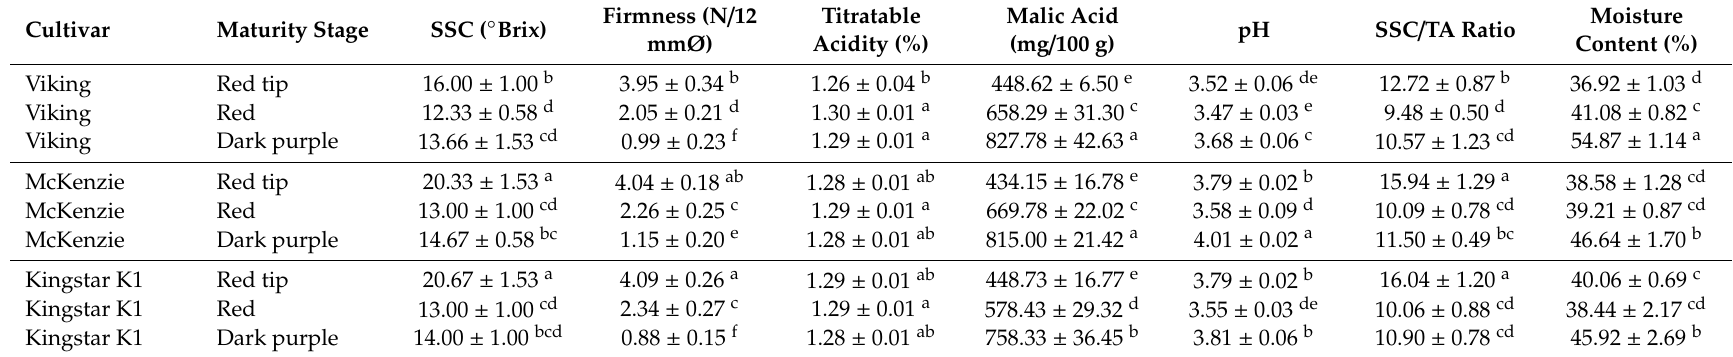
Table 2. Soluble solid contents (SSC), firmness, titratable acidities, pH and moisture content of Aronia melanocarpa fruits at di ff erent maturity